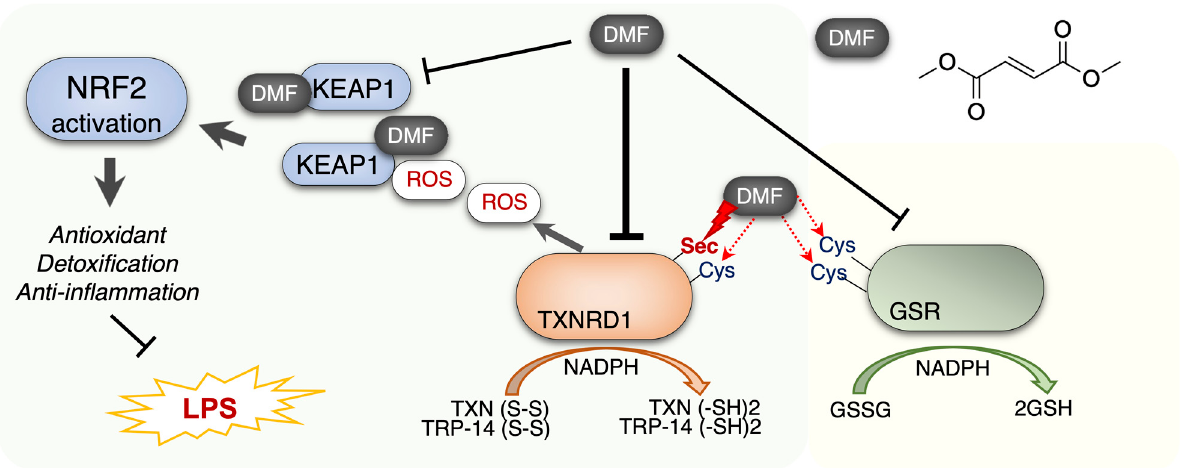
Figure 7. Proposed mechanism of DMF activating the NRF2 transcription but inhibiting TXNRD1 activity. NRF2, Nuclear factor erythroid-2-related factor 2; KEAP1, Kelch-like ECH-associated protein 1; ROS, Reactive oxygen species; TXNRD1, Thioredoxin reductase 1; GSR, Glutathione reductase; LPS, Lipopolysaccharide; DMF, Dimethyl fumarate.